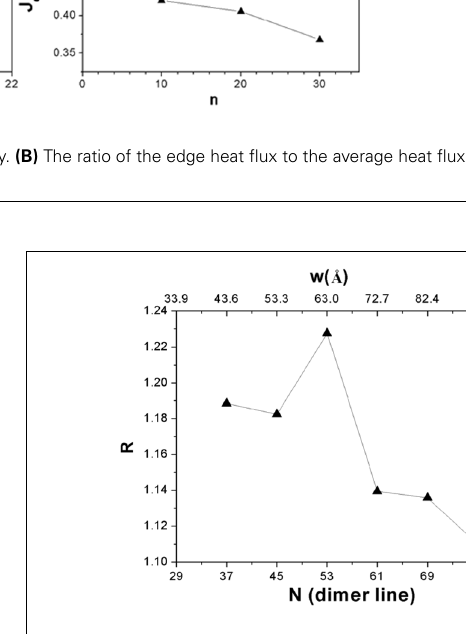
FIGURE 5 | The average heat flux enhancement ratio vs. GNR width. There is an optimal width to maximize this enhancement